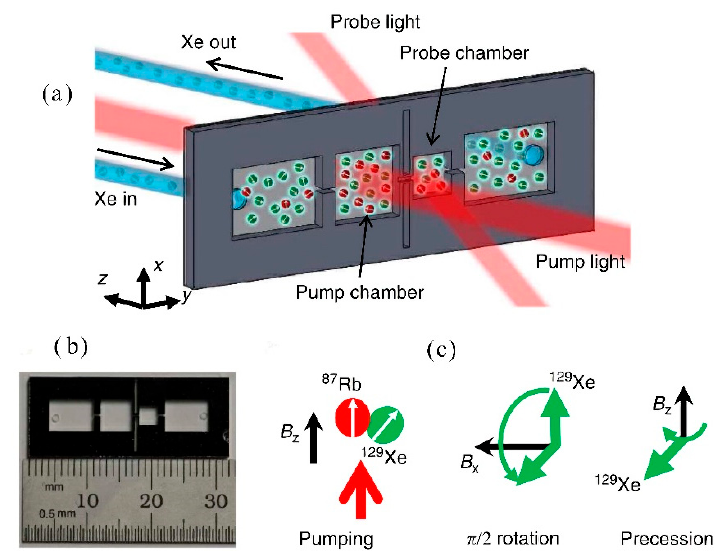
Figure 9. The micro-fluidic chip 129 Xe. ( a ) A gas mixture containing 400 Torr N 2 and 200 Torr Xe in natural isotopic abundance flows from a bulk gas manifold into the inlet chamber, through the pump and probe chambers, and out of the outlet chamber. The chip is loaded with 2 mg of 87 Rb. The 129 Xe then moves downstream, passes through a micro-channel into the probe chamber, and eventually exits the device through the output chamber. The optical characterization of the 129 Xe polarization in the pump and probe chambers is carried out using the ensemble of 87 Rb atoms in each chamber as in situ magnetometers. ( b ) The silicon chip footprint is 3 cm × 1 cm, with a thickness of 1 cm. The dimensions of the pump and probe chambers are 5 × 5 × 1 cm 3 and 3 × 3 × 1 cm 3 , respectively, whereas that of the channel connecting the pump and probe chambers is 1 × 0.3 × 0.3 cm 3 . Two tall narrow grooves are etched from the middle of the chip to provide thermal isolation between the two sides of the device. ( c ) Pumping and probing sequence for 129 Xe. Pumping is carried out continually in the pump chamber in the presence of a longitudinal field of B z = 0.8 µ T. Every 10–20 s, a transverse DC field of magnitude 5.3 µ T is switched on for 4 ms to tip the 129 Xe atoms onto the xy-plane and initiate the 129 Xe precession about the longitudinal axis. Reprinted from ref.